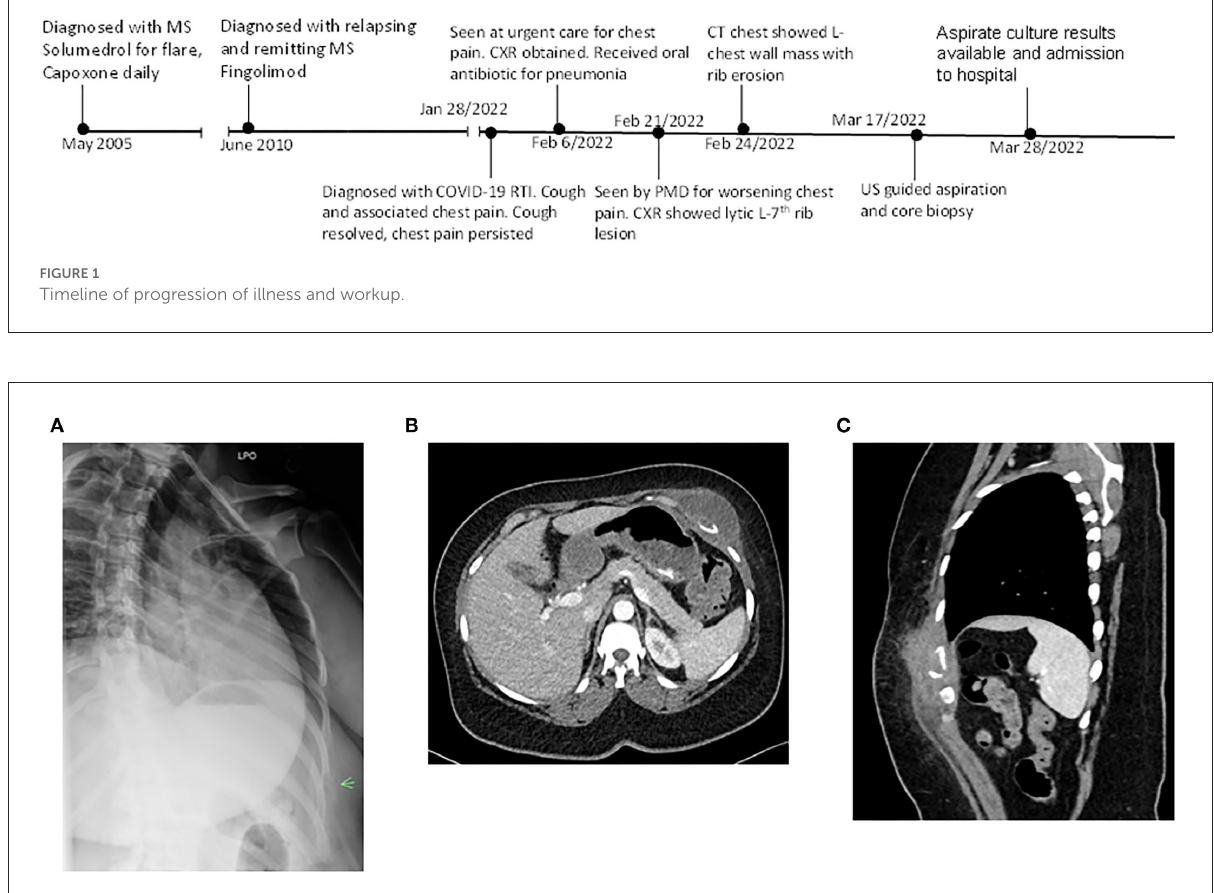
FIGURE2 Imaging findings of chest wall mass and rib osteomyelitis. (A) Chest X-ray shows destruction of a rib. (B) Left chest wall mass (axial image). (C) Left chest wall mass (coronal view). Green arrow indicates the level of 7th rib fracture and mass.